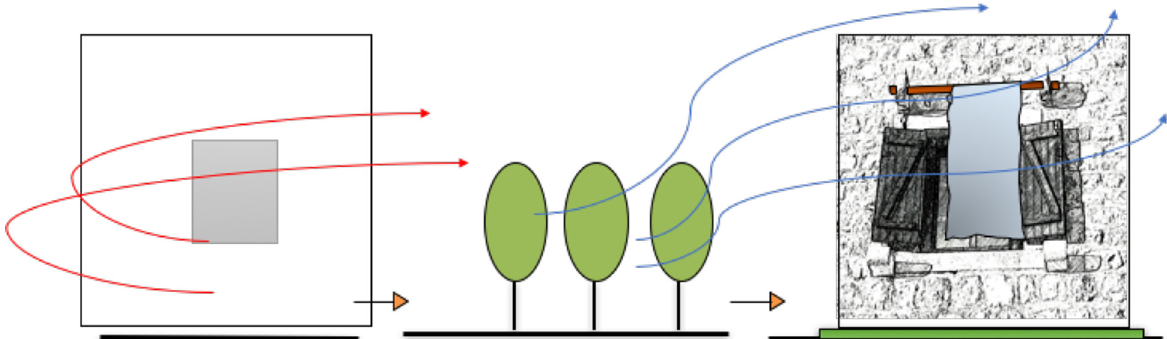
Fig. 10. Differences in the use of urban sustainable design, preferred revitalisation method for natural cross